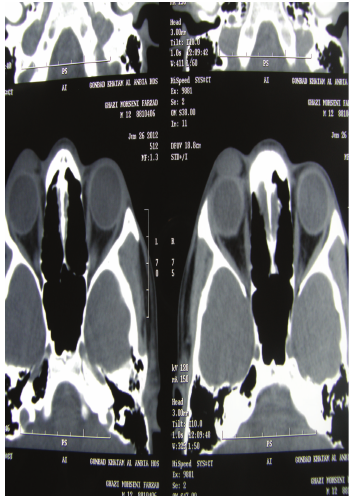
Figure 2: Axial and coronal view of orbital CT scan that showed well-circumscribed, uniform preseptal mass without orbital exten- sion.